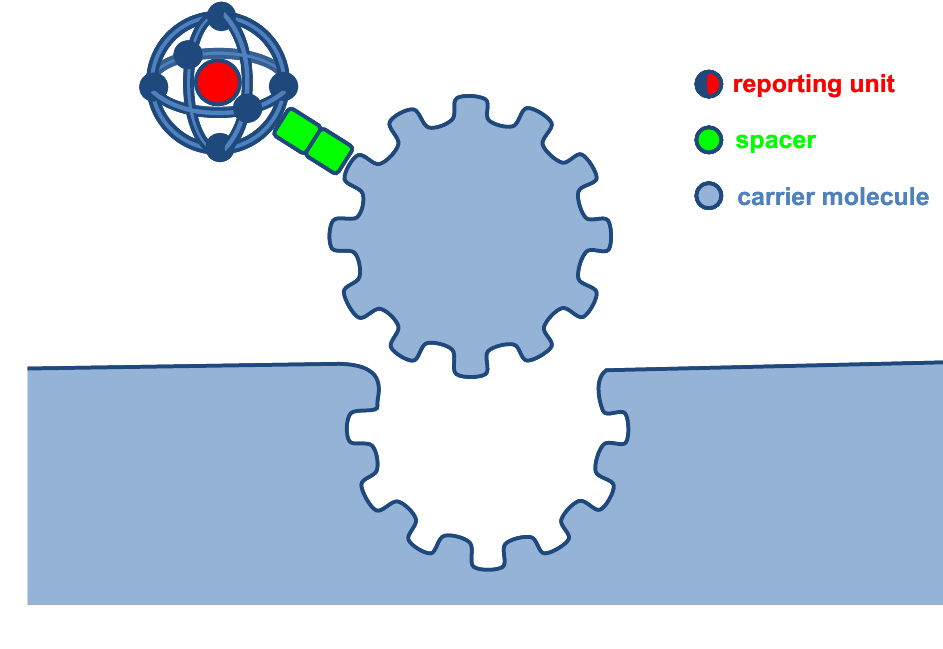
Figure 1. Binding of ligand to target like a peptide-receptor has been visualized by a “lock and key” arrangement, where the peptide fits into a binding pocket of the receptor on the surface of tumor cells in a similar manner to a key fitting into a